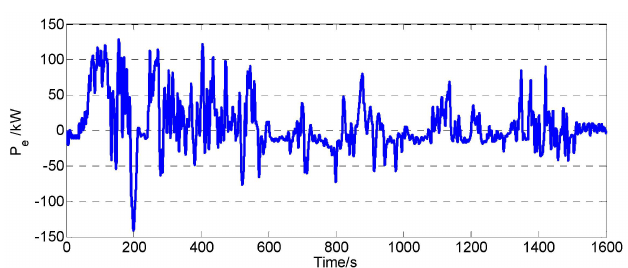
Figure 11. Allocation results for electrical power.